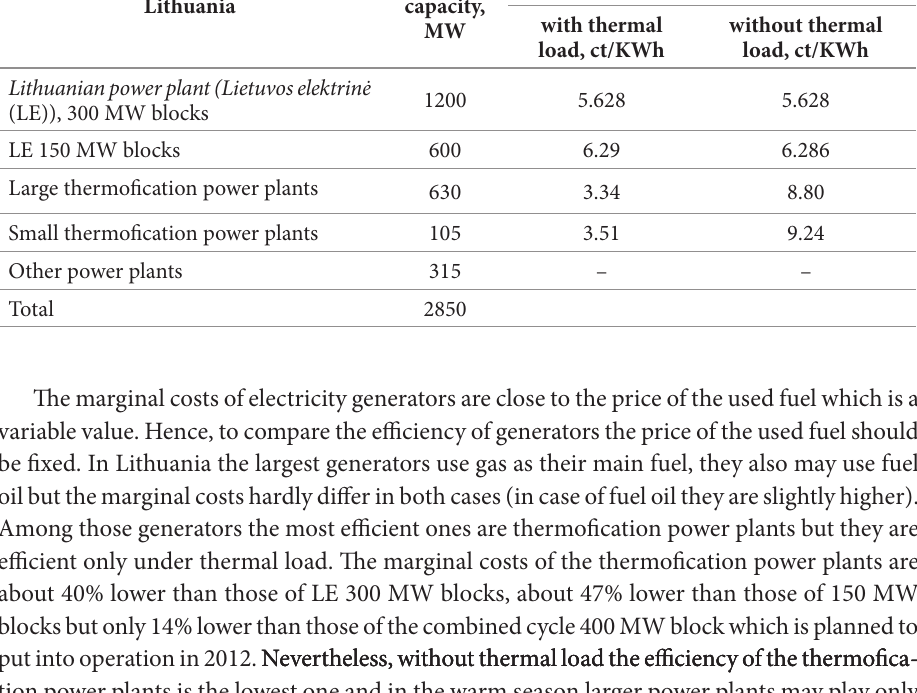
Estimated capacity, without thermal MW with thermal load, ct/KWh load,